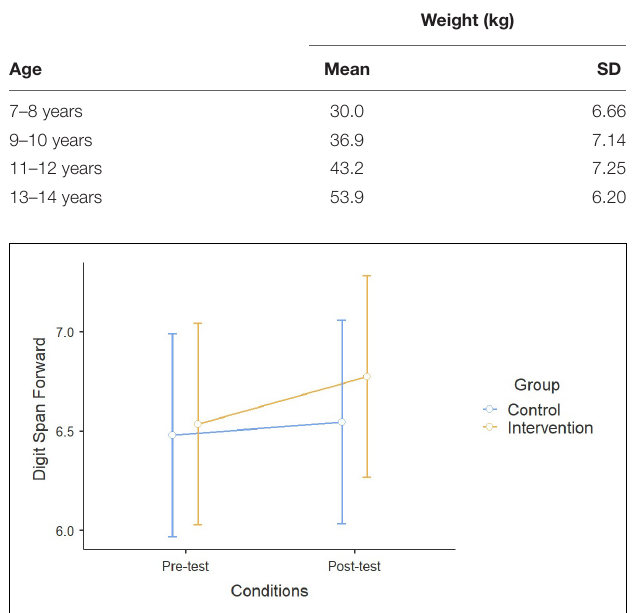
TABLE 3 | Distribution of weight in different age ranges.